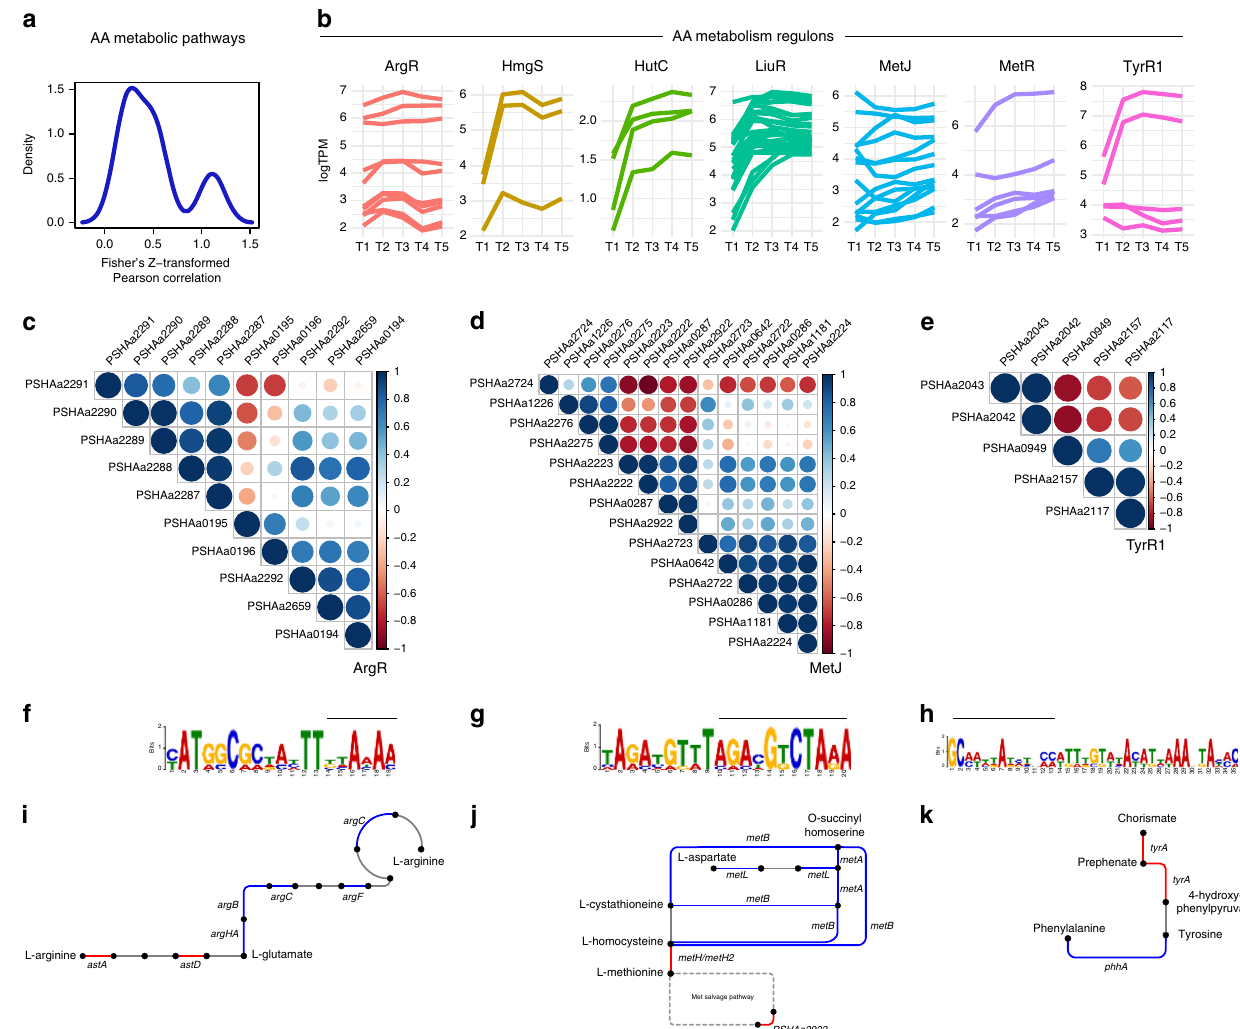
Fig. 3 Deregulation of amino acid metabolic pathways. a Cumulative density plot of Fisher ’ s Z transformation average of Pearson correlation expressing the co-regulation of genes belonging to the same pathway. b Log 2 -transformed TPM values of the genes belonging to the same regulon. c – e Graphic representation of the Pearson correlation matrix for the genes belonging to the regulons showing the lowest average correlation, Arginine metabolism/ biosynthesis, Methionine biosynthesis and Aromatic amino acids metabolism. Locus tags in bold indicate those of the regulator of the corresponding regulon. f – h Show the conserved upstream motif found for each gene of the considered regulon. The bar above each conserved motif indicates the overlap existing with the known TF binding site according to the RegPrecise database. Finally, in ( i – k ) the reactions encoded by the genes included in the same regulon are schematically represented. Red and blue lines schematically represent the correlation coef fi cient of Fig. 3c, d. Source data are provided as a Source Data fi